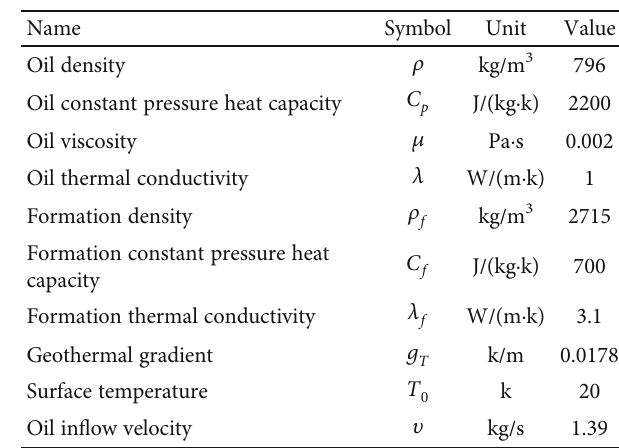
Table 1: Simulation